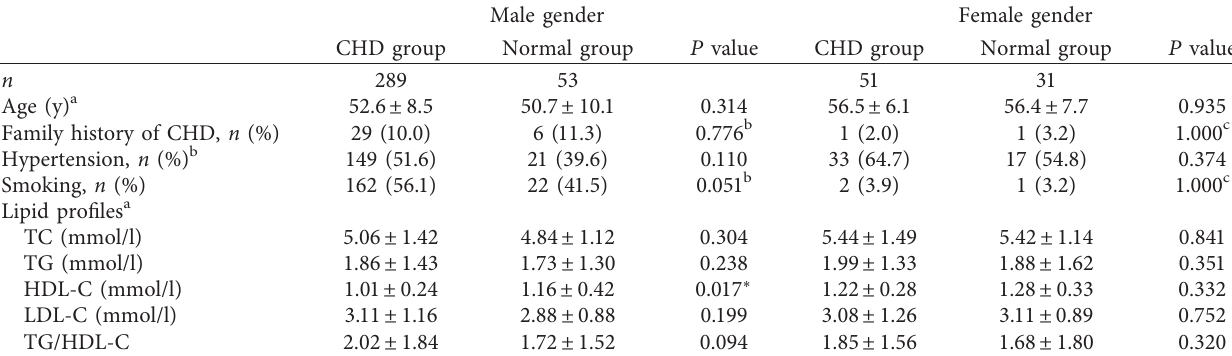
Table 2: Characteristics of patients without diabetes in the CHD group and normal group in different genders.